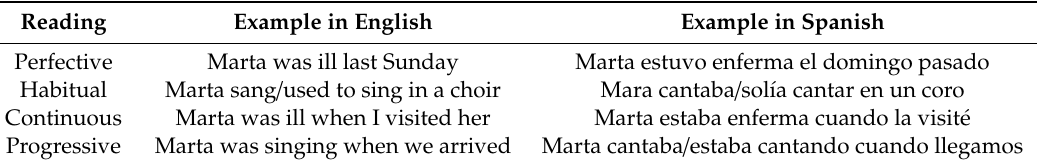
Table 1. Examples of each of the four readings in Arche (2014) approach to viewpoint aspect, taken from Dom í nguez et al. (2017, p.